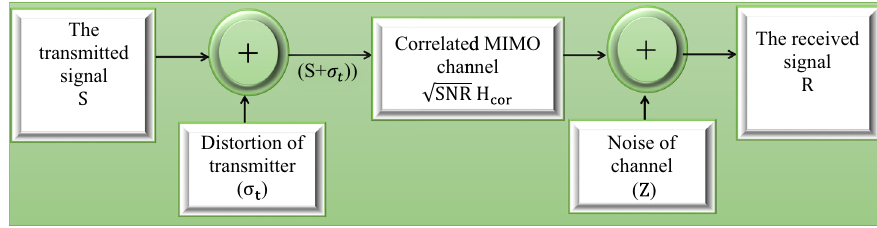
Figure 1: Block diagram of the a ffi ne correlated MIMO channel model in the presence of the physical